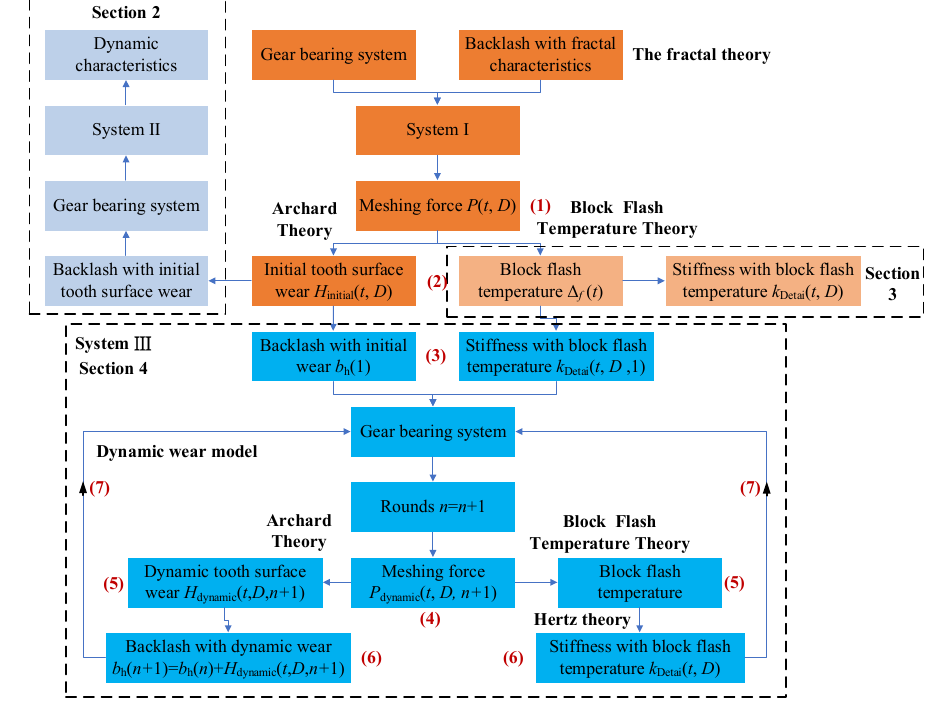
Figure 8. Flow chart of dynamic wear